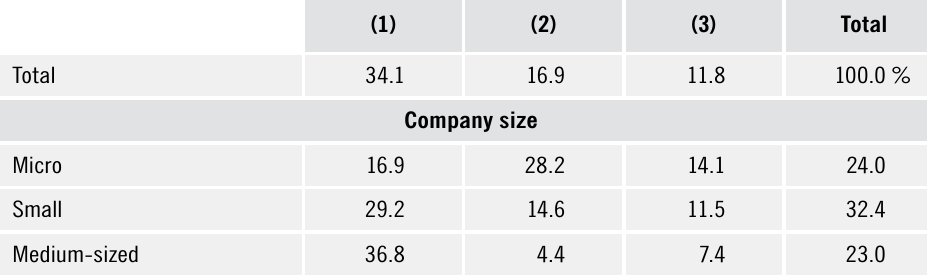
Table 2. Overview of descriptive statistics: categorical variables (%), N=296